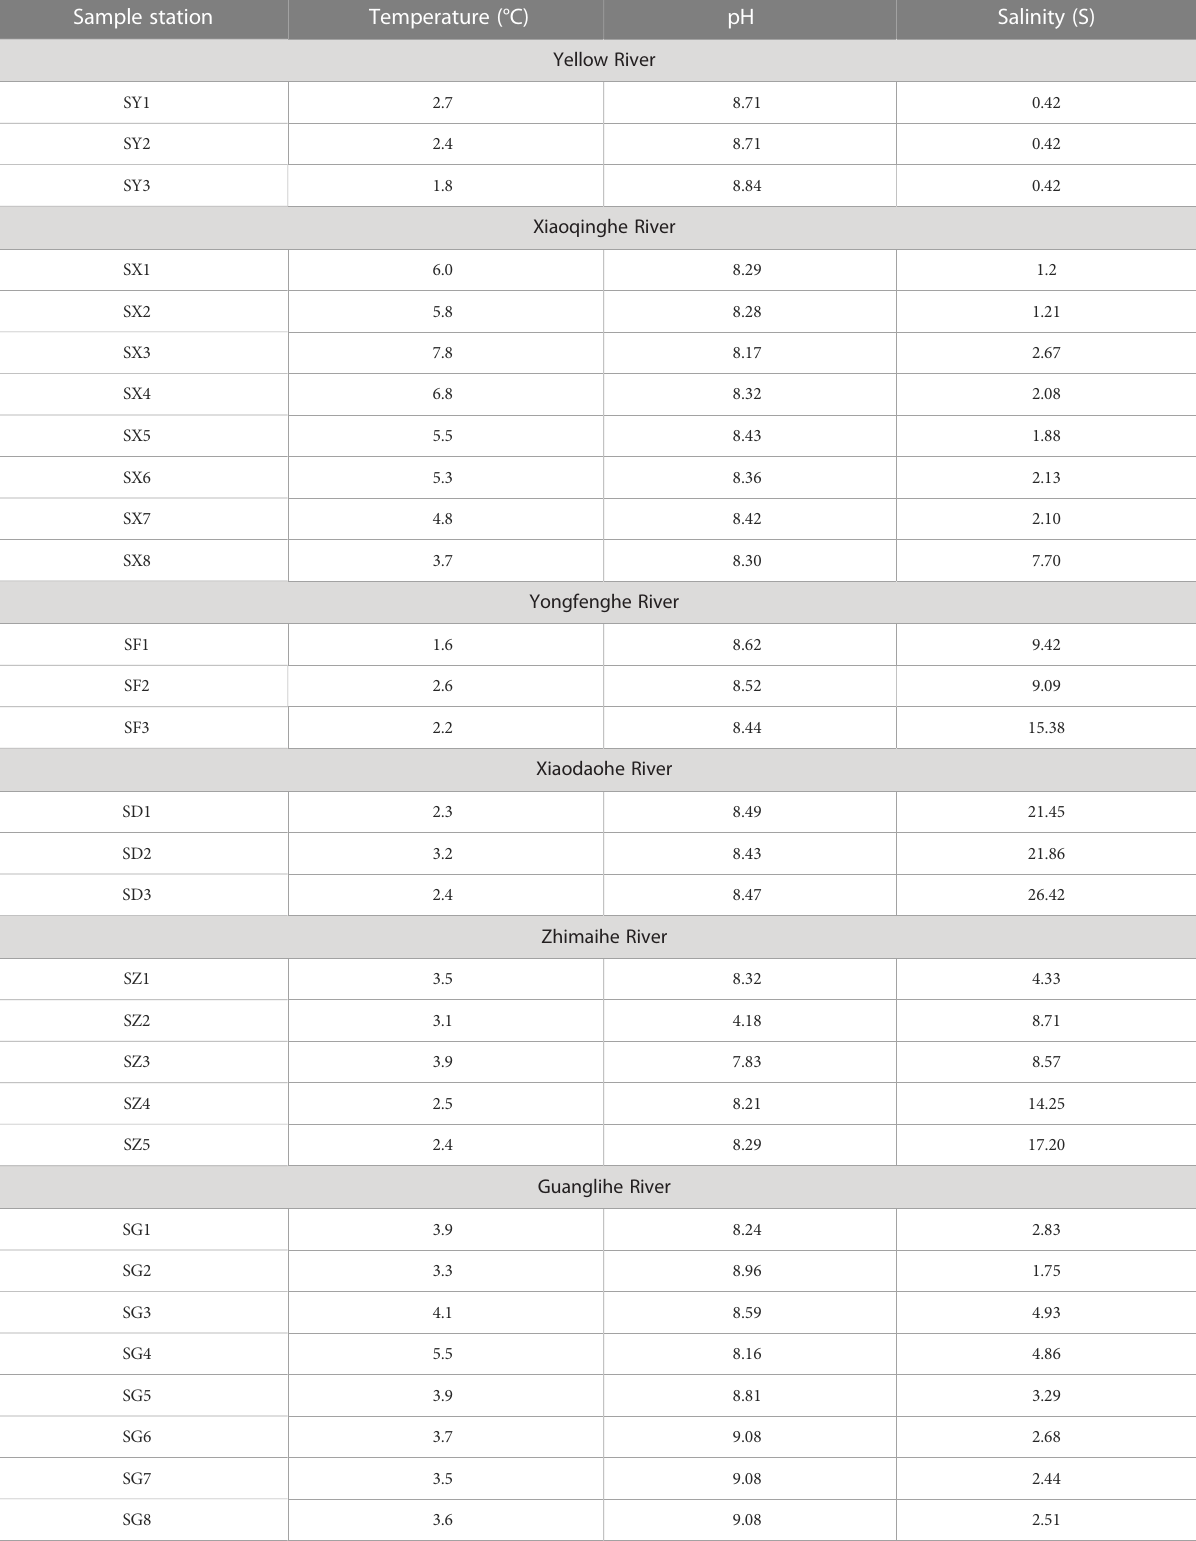
TABLE 2 Hydrographic parameters, such as water temperature, salinity, and pH of the